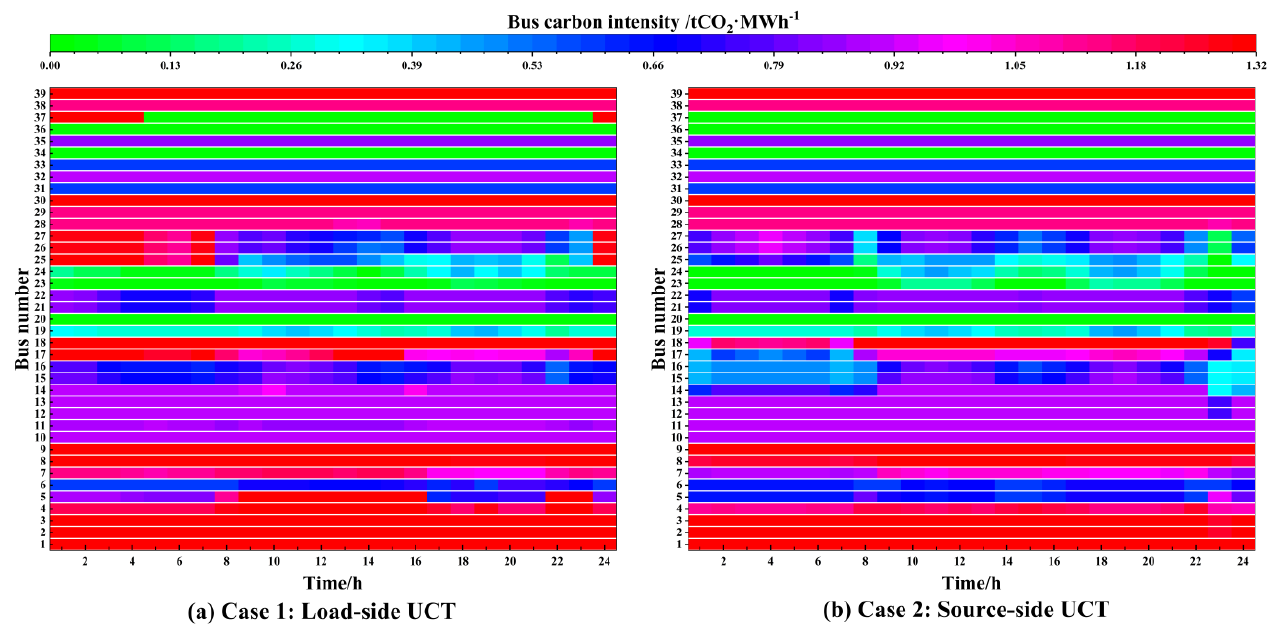
Figure 11. The optimized carbon intensities of each bus in Case 1 and Case 2.